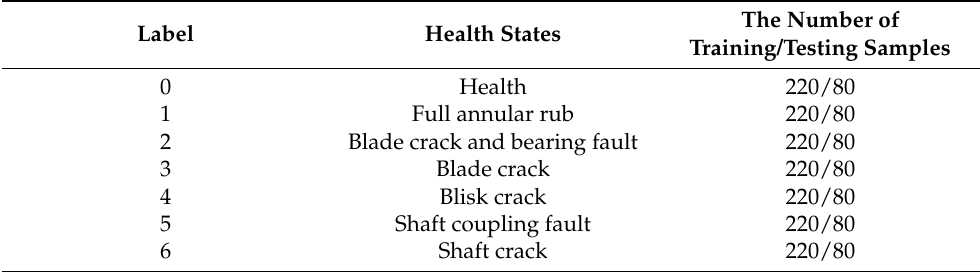
Table 3. Seven health states of the rotor.